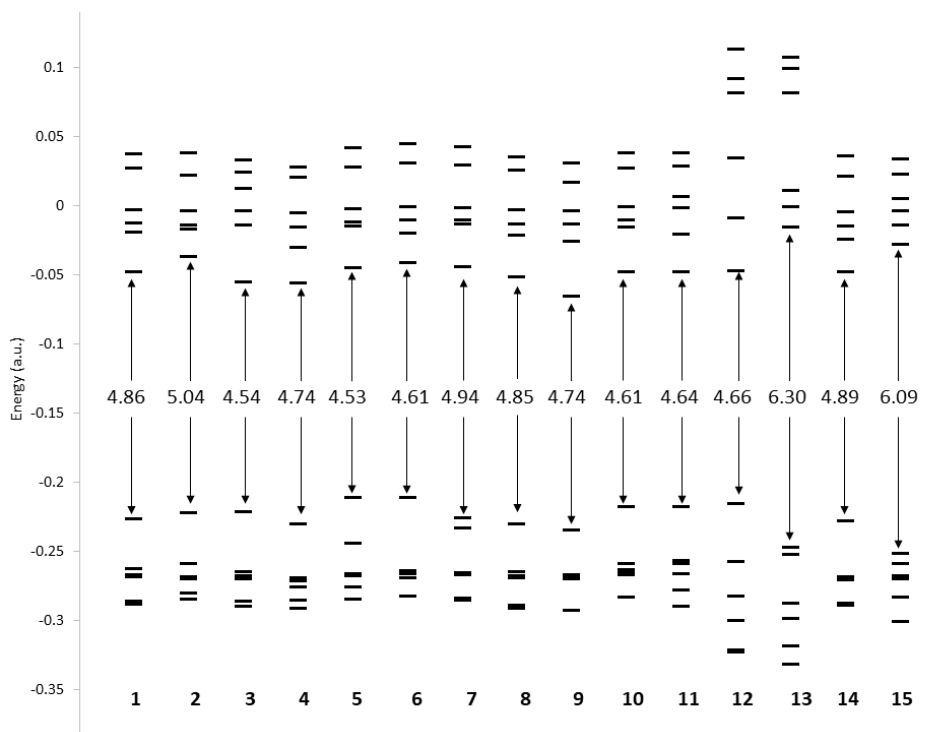
Figure 3. Frontier molecular orbital (FMO) energy diagrams (a.u.) and HOMO – LUMO gaps (eV) calculated at the DFT level of theory for compounds 1 – 15 .